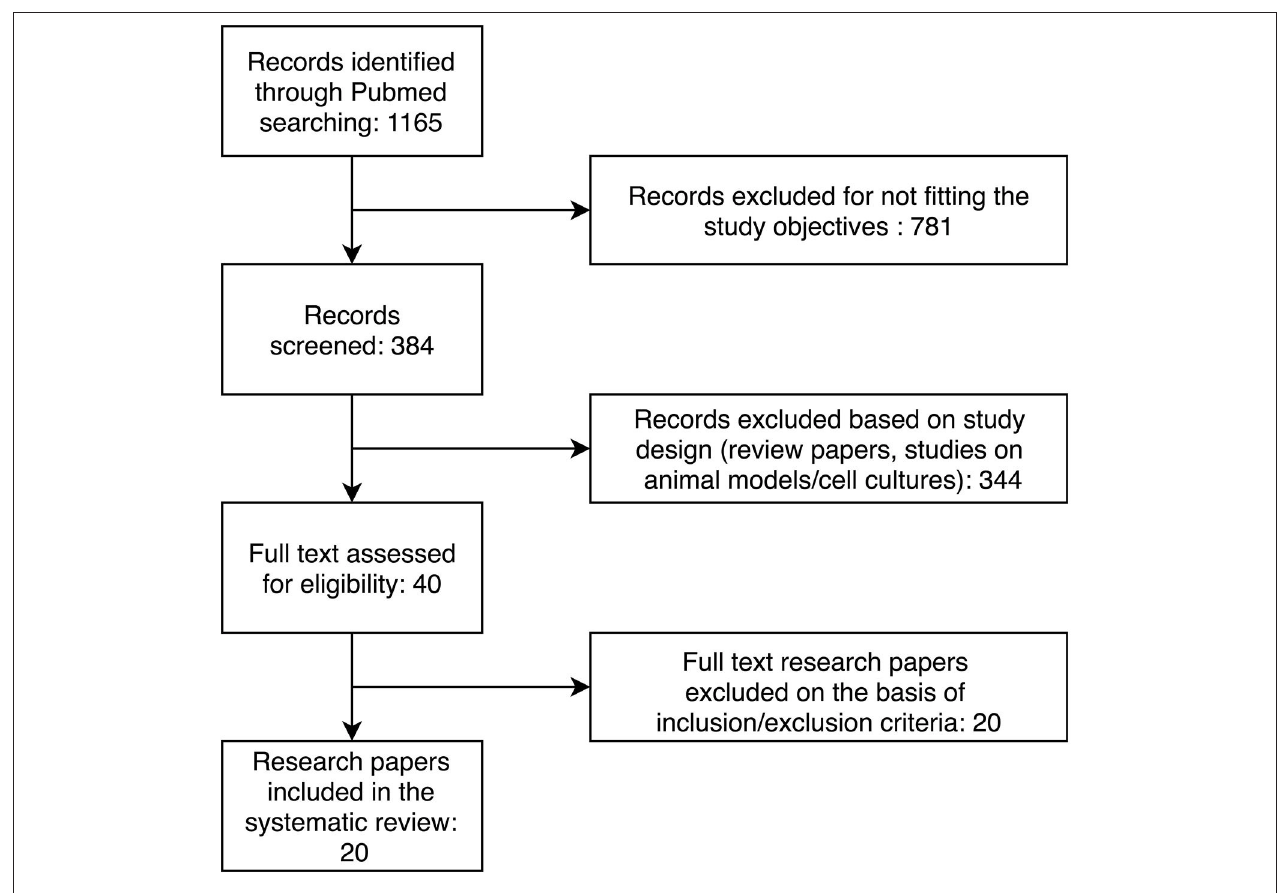
FIGURE 1 | Flow diagram of the study selection